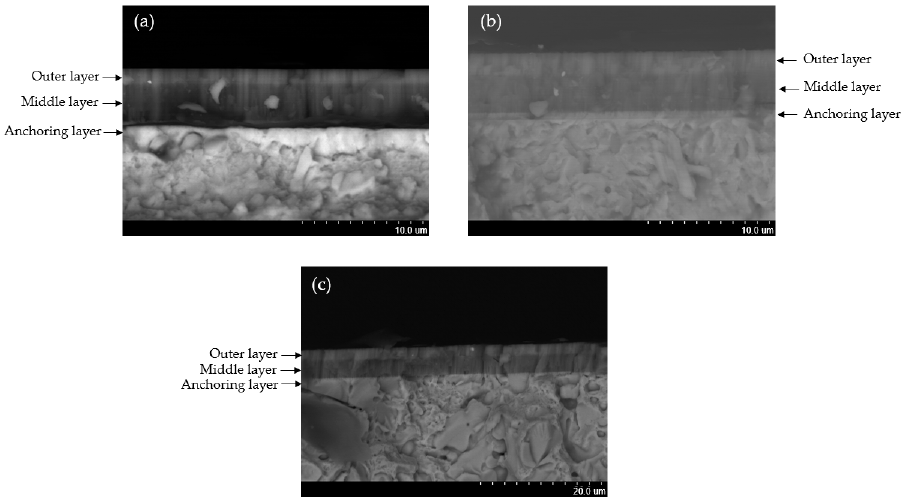
Figure 3. Cross-section SEM pictures with the coating’s structure. The 1.2379 + Duplex sample ( a ), Vanadis 4 + Duplex sample ( b ) and 1.2379 + PVD sample ( c ).